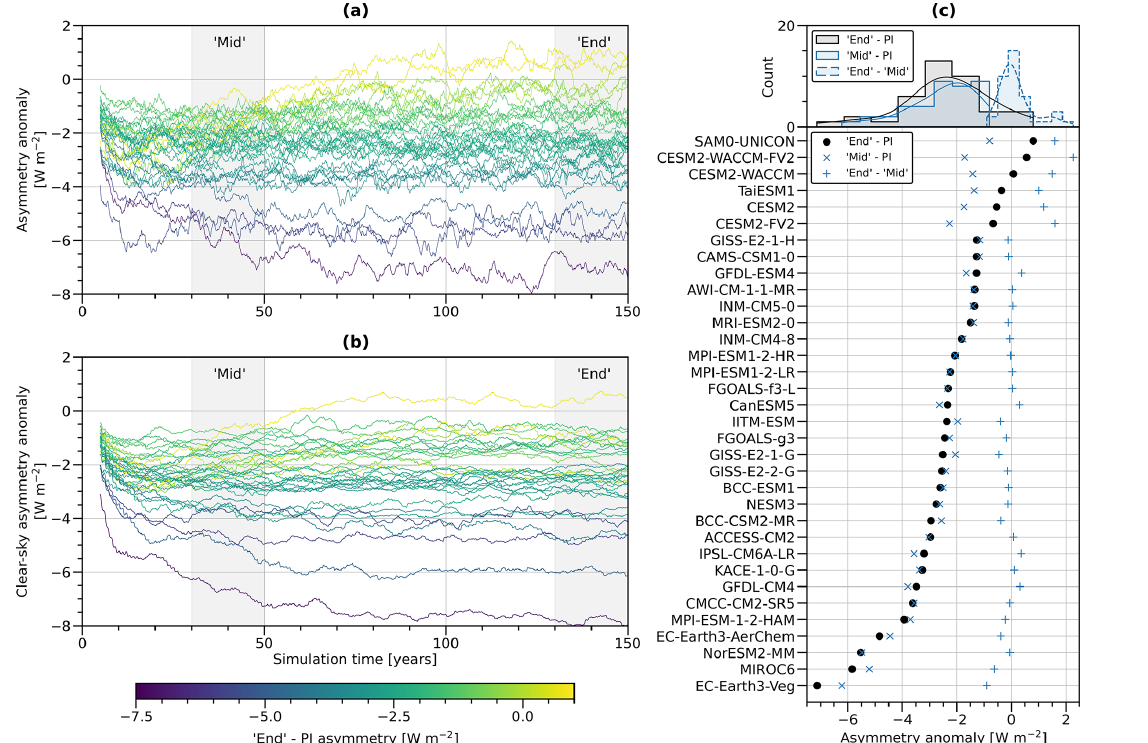
Figure 1. (a, b) Time series of 5-year running mean modeled (a) all-sky and (b) clear-sky asymmetry responses in abrupt-4xCO2 sim- ulations. The color scale of time series lines is representative of the total End minus PI albedo asymmetry difference. (c) Differences in mean asymmetries between periods, listed in order of End minus PI asymmetry changes. Histograms (with eight bins; also shown as curves smoothed with a Gaussian kernel) of the distributions of asymmetry responses by period are shown at the